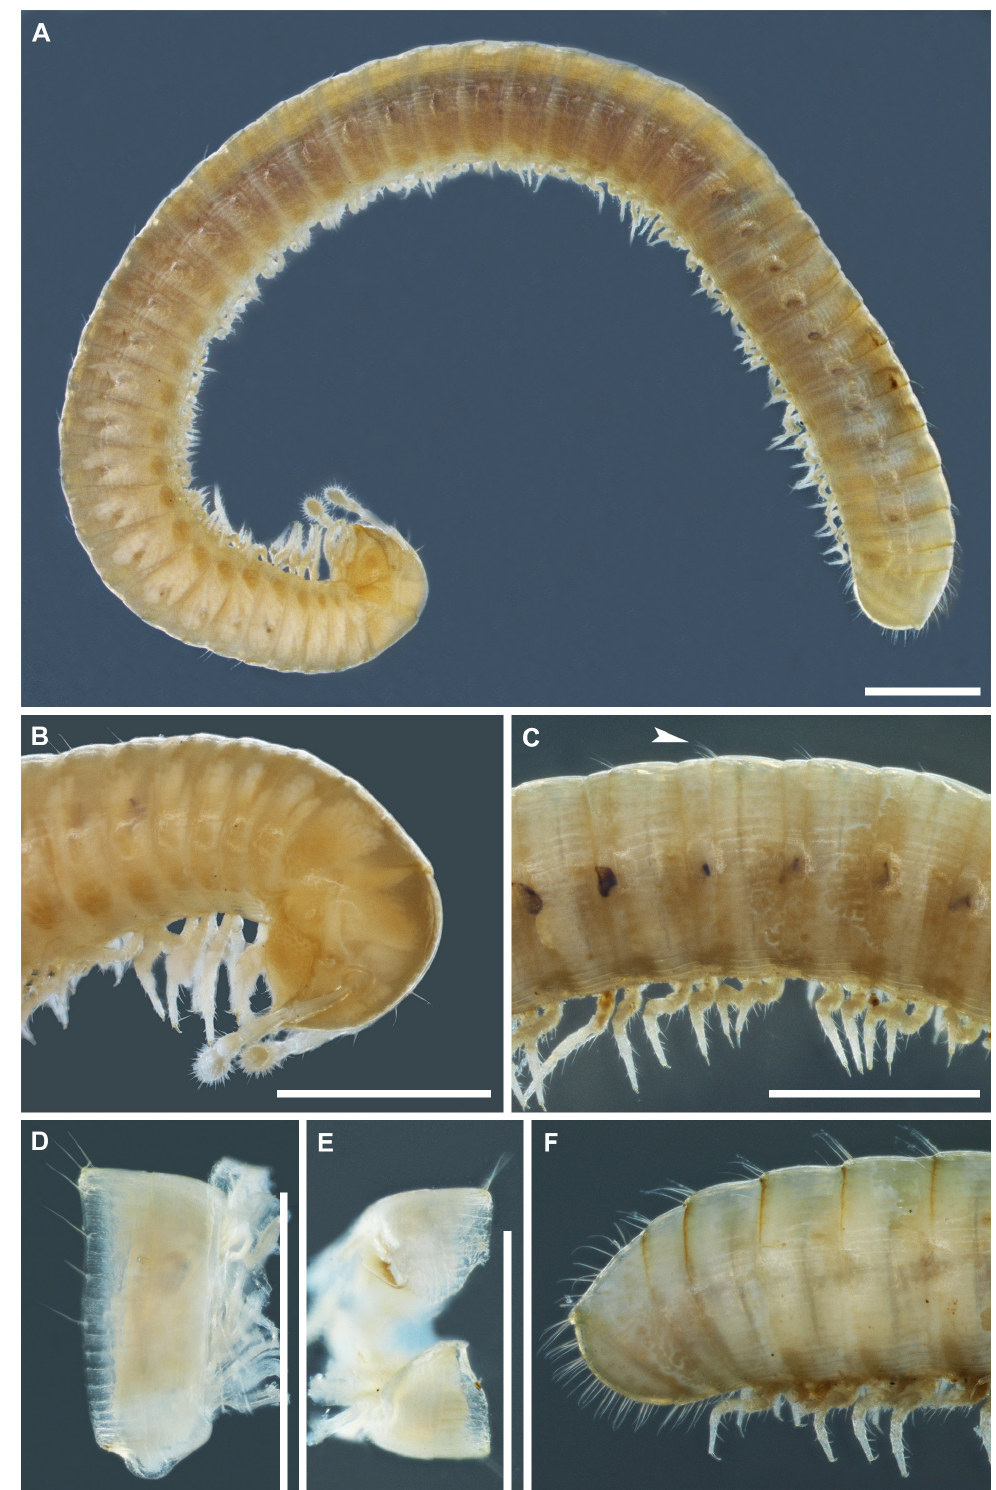
Fig. 14. Leucogeorgia satunini (Lohmander, 1936) comb. nov., ♀ and ♂ from Kelasurskaya Cave (ZMUM). A . ♀, habitus, lateral view. B . ♀, anterior part of body, lateral view. C . ♂, midbody rings, lateral view. D . ♂, body ring 7, lateral view. E . ♂, body ring 7, ventral view. F . ♂, posterior part of body, lateral view. Scale bars: 1